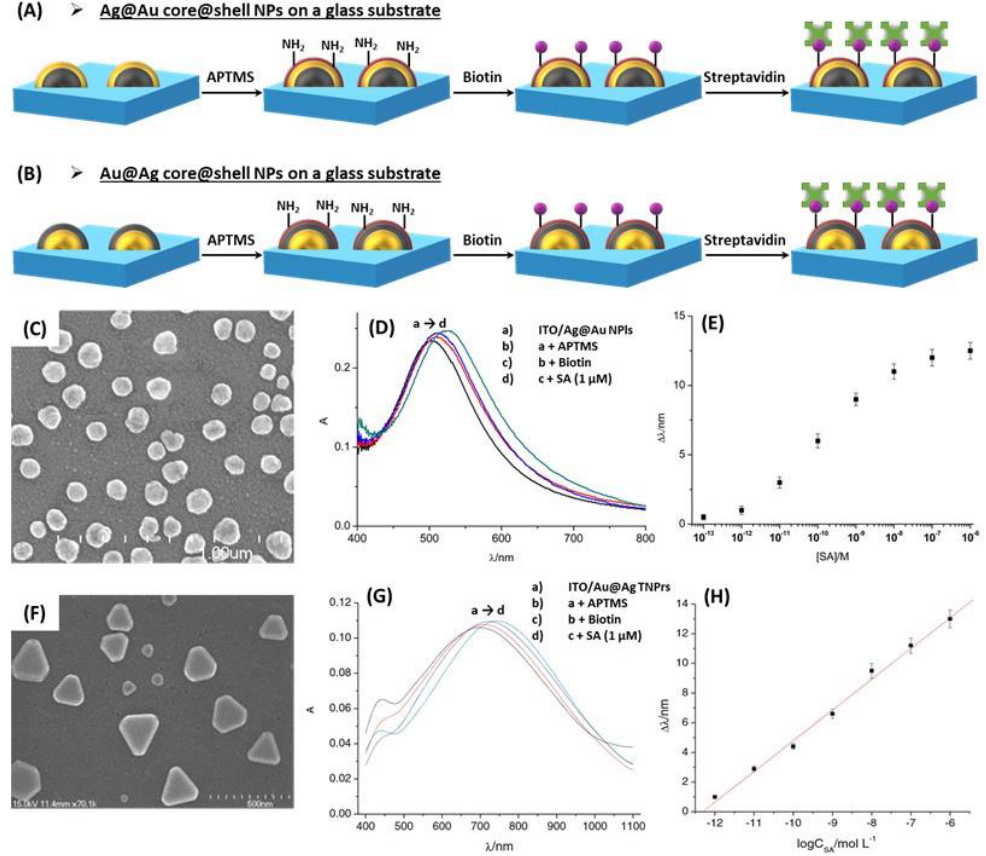
Figure 24. ( A , B ) Schematic illustration showing the preparation of glass-supported core@shell NPs for SA biosensing. ( C ) SEM image of Ag@Au hemispherical nanoplates supported on ITO glass. ( D ) LSPR peak (500 nm) was shifted upon successive treatments with APTMS, biotin and SA. ( E ) Relationship between the LSPR band shift and SA concentration for Ag@Au NPls. ( F ) SEM image of Au@AgTNPls supported on ITO glass. ( G ) LSPR peak (700 nm) shifted upon successive treatment with APTMS, biotin and SA. ( H ) Linear relationship between the LSPR band shift and SA concentration. Adapted from [152,157]. Copyright (2013), American Chemical Society. Copyright